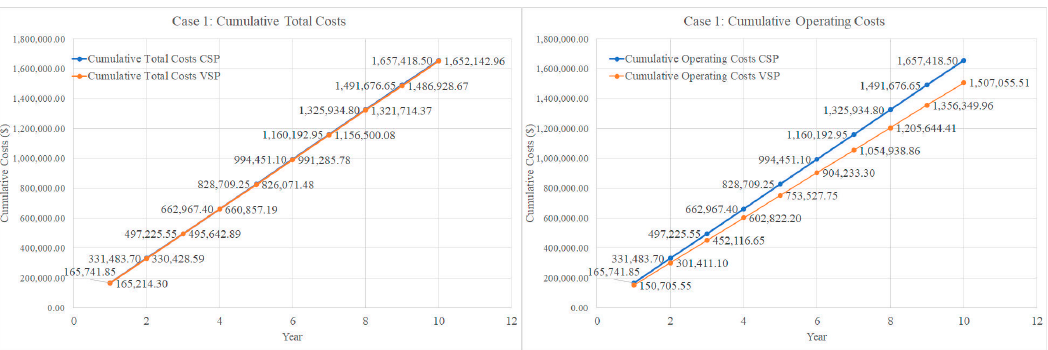
Figure 7. Case 1: Cumulative total (left) and operating (right) costs with both constant speed pumps (CSPs) and VSPs.